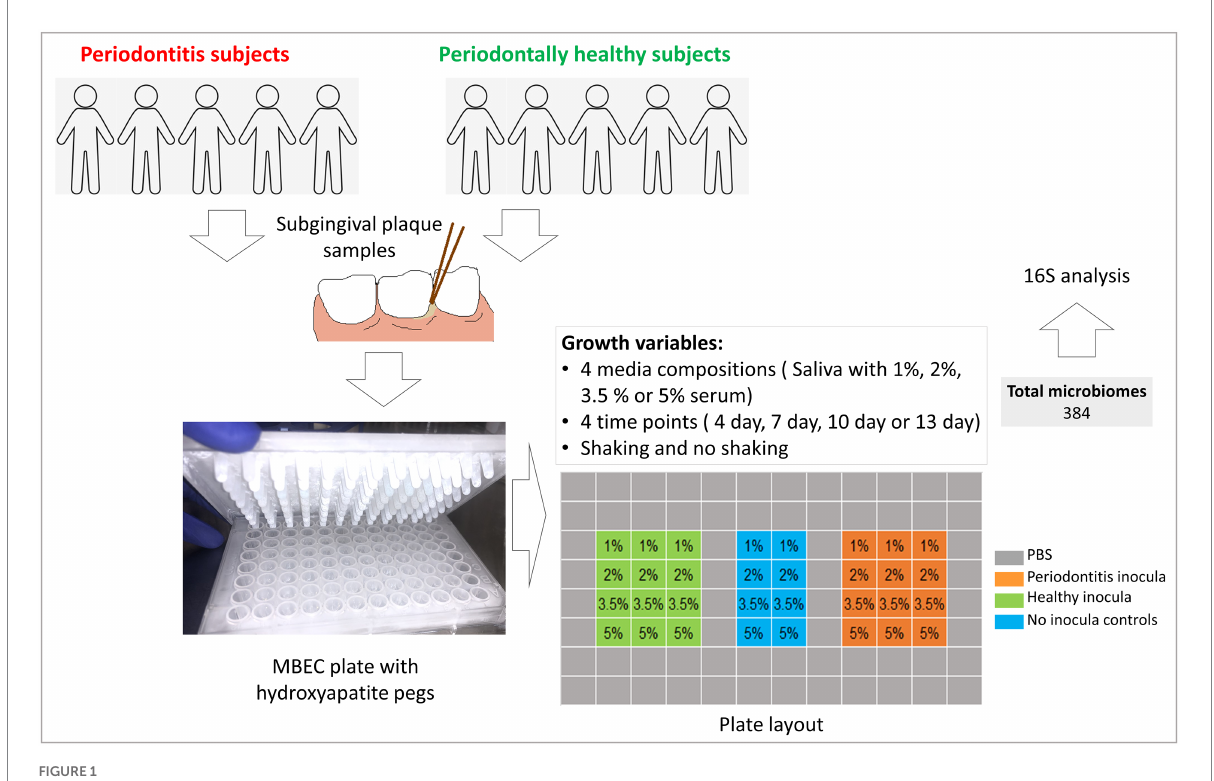
FIGURE 1 A flow chart of study design and